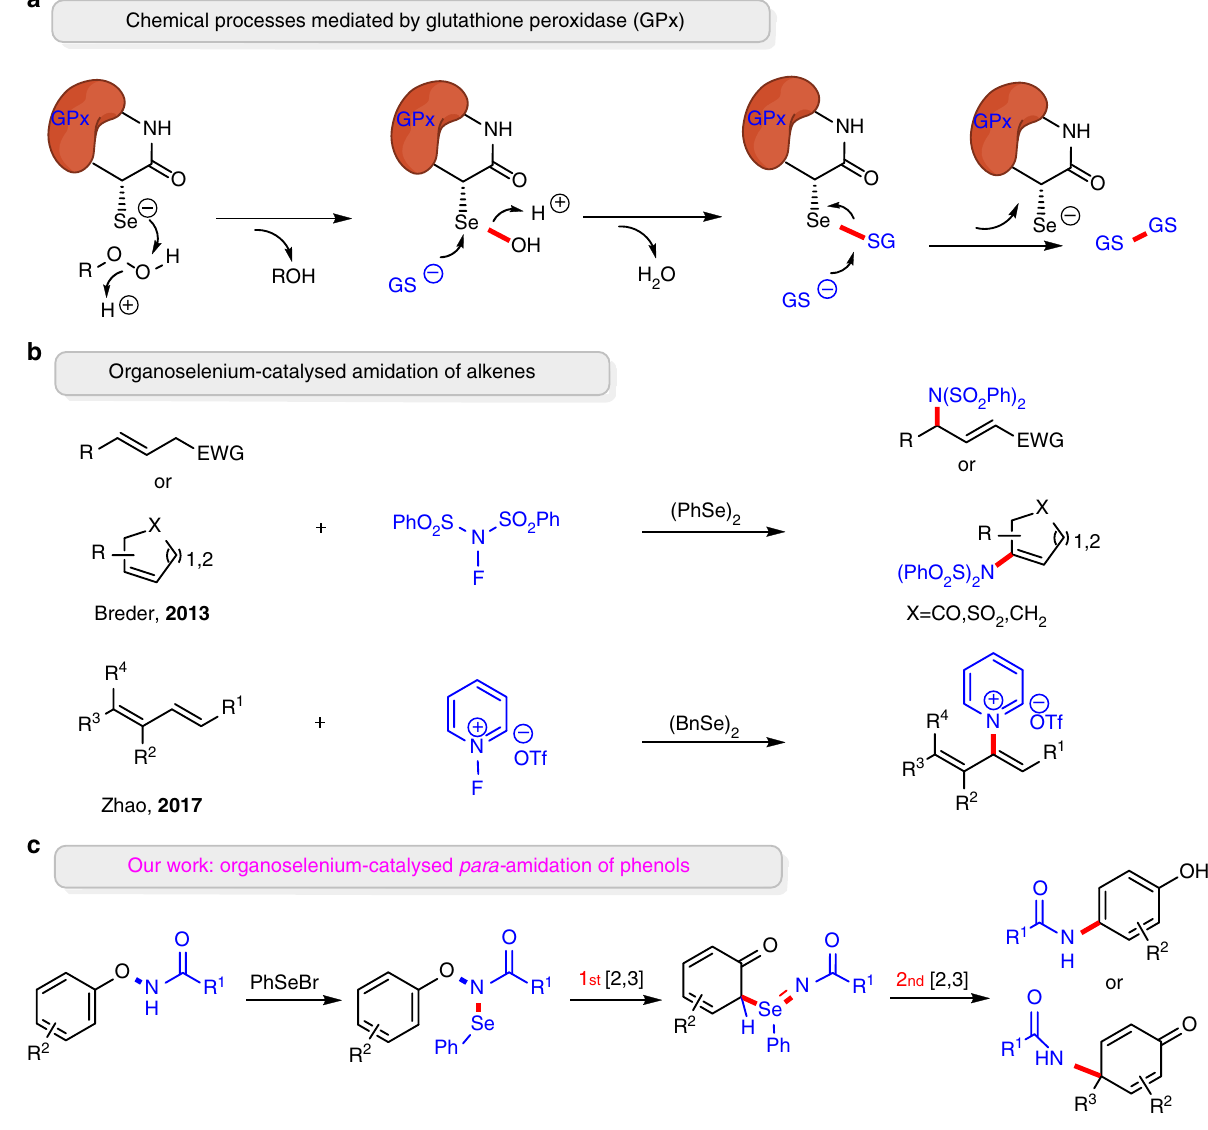
Fig. 1 Selected biological reaction and organic reactions catalysed by selenium. a Proposed catalytic cycle of glutathione peroxidase (GPx) for the reduction of hydroperoxides in biology. b Previous reports on organoselenium-catalysed amination of alkenes. GS − glutathione. c Our double [2,3]-sigmatropic rearrangement to achieve para -amination of